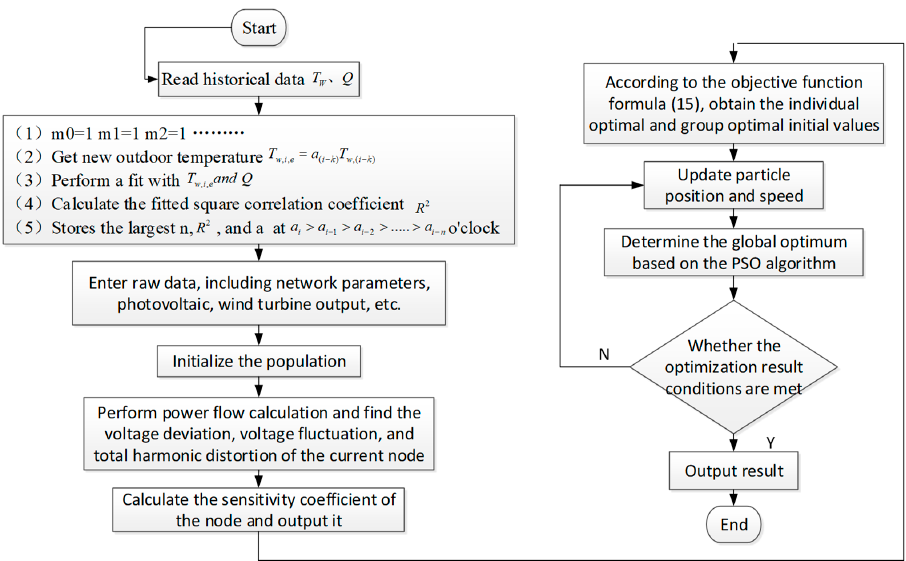
Figure 3. Improved particle swarm optimization algorithm flowchart.